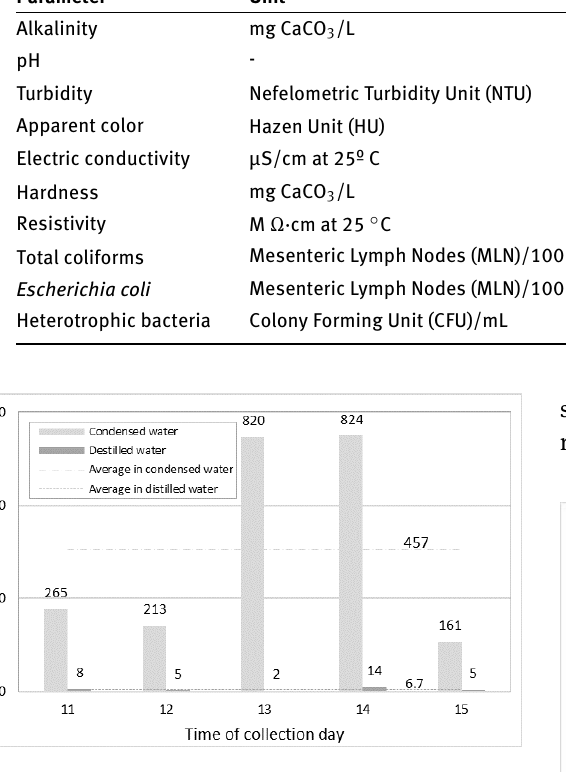
Figure 3: Quantity of heterotrophic bacteria in CFU/ml found in distilled and condensed water throughout the monitoring period.